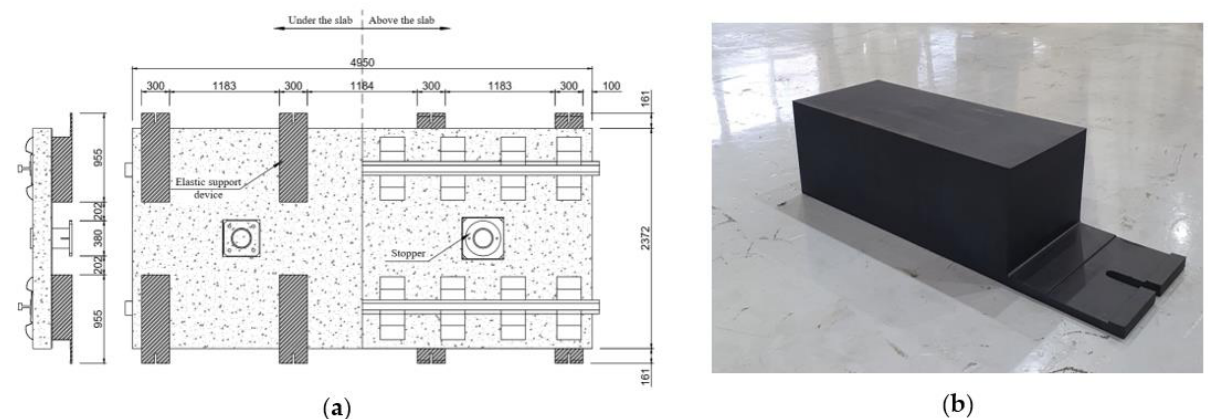
Figure 4. Precast-Fast Improvement slab Track (Type II): ( a ) Detailed structures, ( b ) Rubber Elastic Support Device.